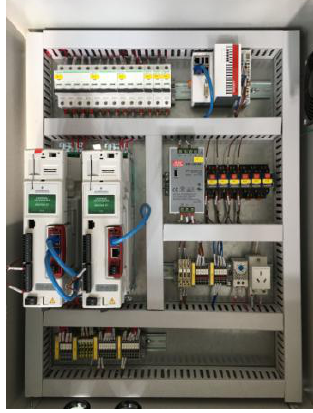
Fig. 13. Control modular of the steering mirror